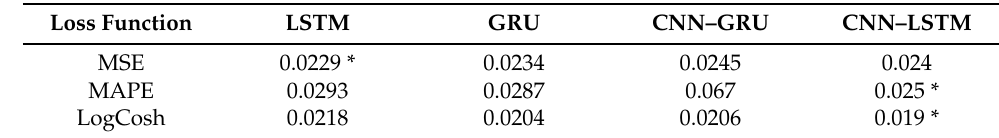
Table 5. MAE obtained by the models under study in terms of the used loss function on the traffic speed